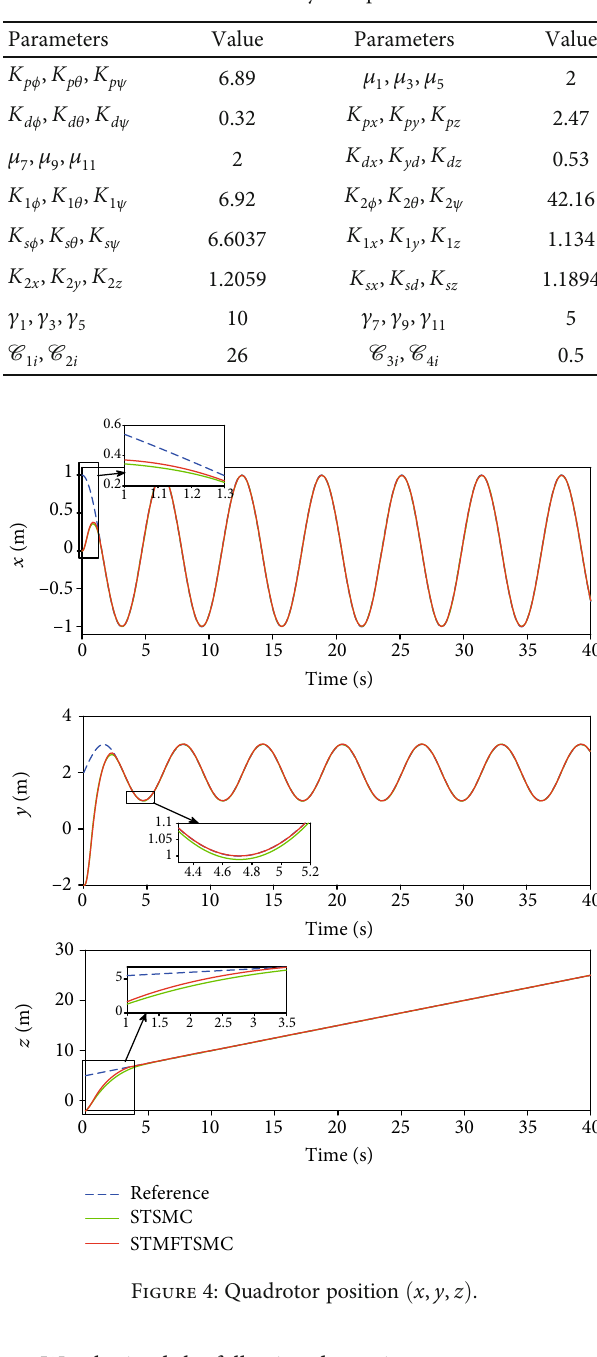
Table 2: Control system parameters.